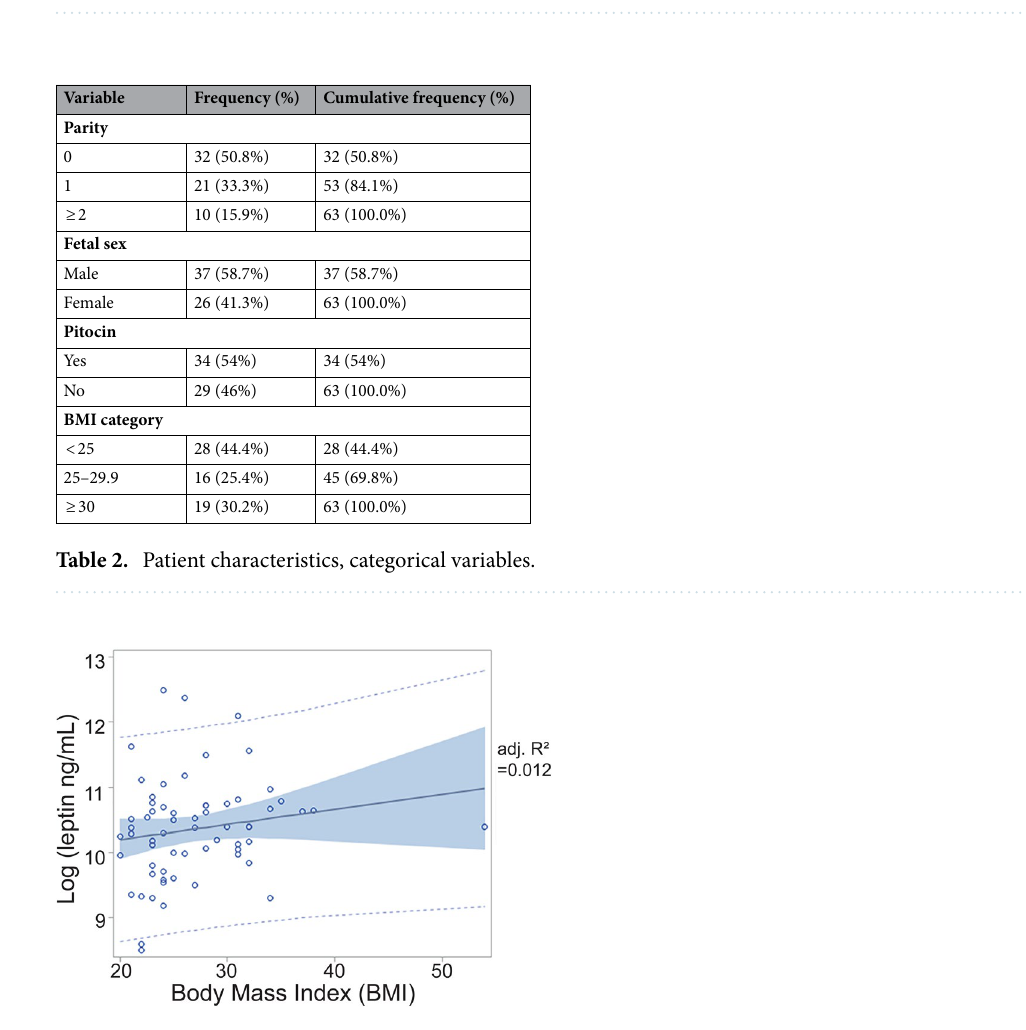
Table 1. Patient characteristics for continuous variables (N = 63).